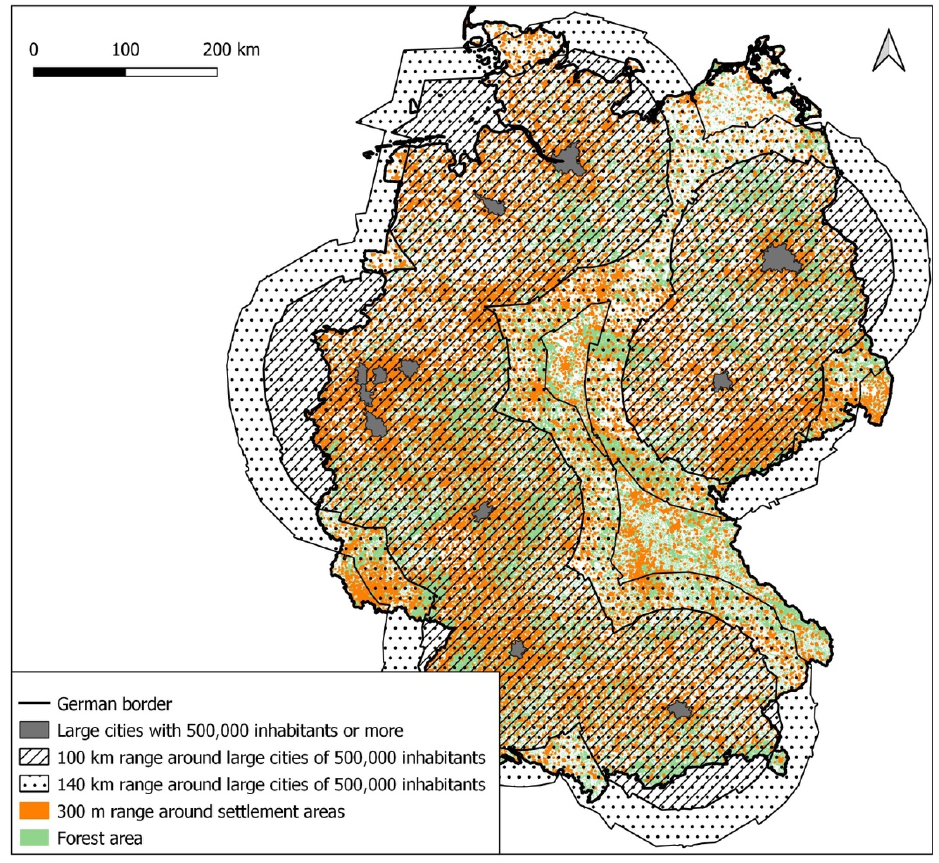
Figure 4. Impact areas around large cities in Germany with populations of 500,000 people and more. With the same type of nuclear weapon, now almost all of Germany would be covered by fallout radiation risk. Only a small stretch from the center to the southeast and some pockets in the very northeast and center-east remain. Two larger cities can be seen in this area in the center that could be used for evacuation planning. Large cities need separate planning because urban areas are highly at risk from the blast, fire, and radiation, which would suggest identifying underground shelters. However, for the areas up to 140 km around those cities, a warning time of 15 min and maybe more would enable evacuation activity. Radiation fallout not only needs time to rain down, but it also propagates with distance. Therefore, areas at the perimeter are likely to have more time to evacuate or seek shelter. Planners of shelter sites in civil protection services could use such information to identify the areas at the outer perimeters of such buffers to designate evacuation sites.